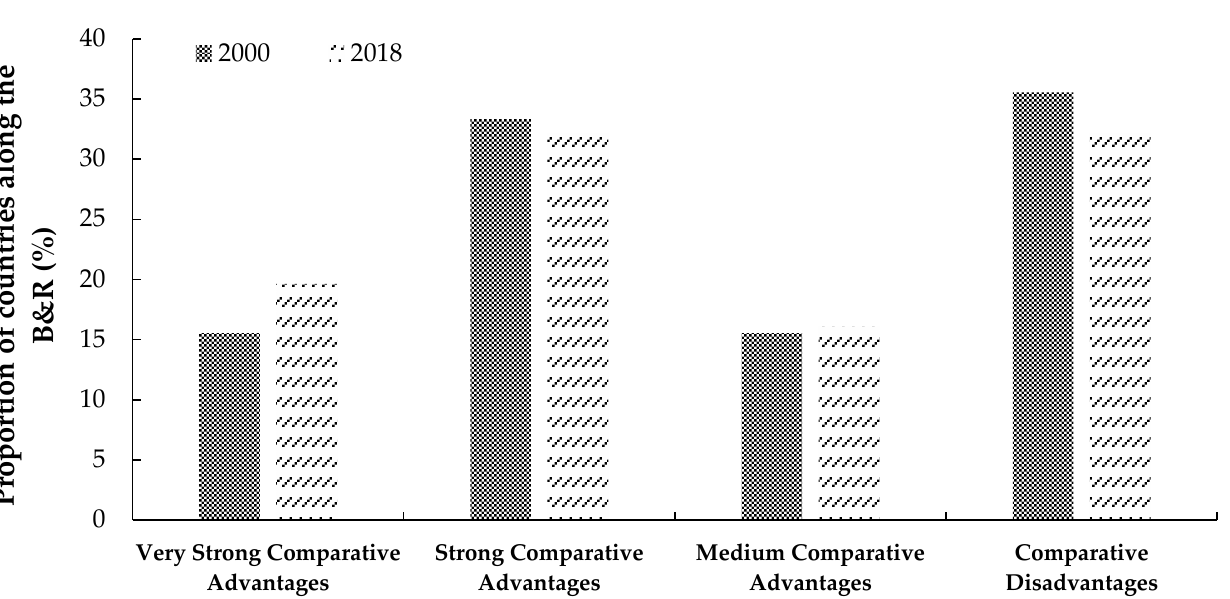
Figure 1. The distribution of comparative advantage of total agricultural trade in countries along the B&R in 2000 and 2018 by using the Balassa RCA index. The x -axis represents different levels of comparative advantage; and the y -axis represents the proportion of number of countries along the B&R with different levels of comparative advantage in 64 countries along the B&R.